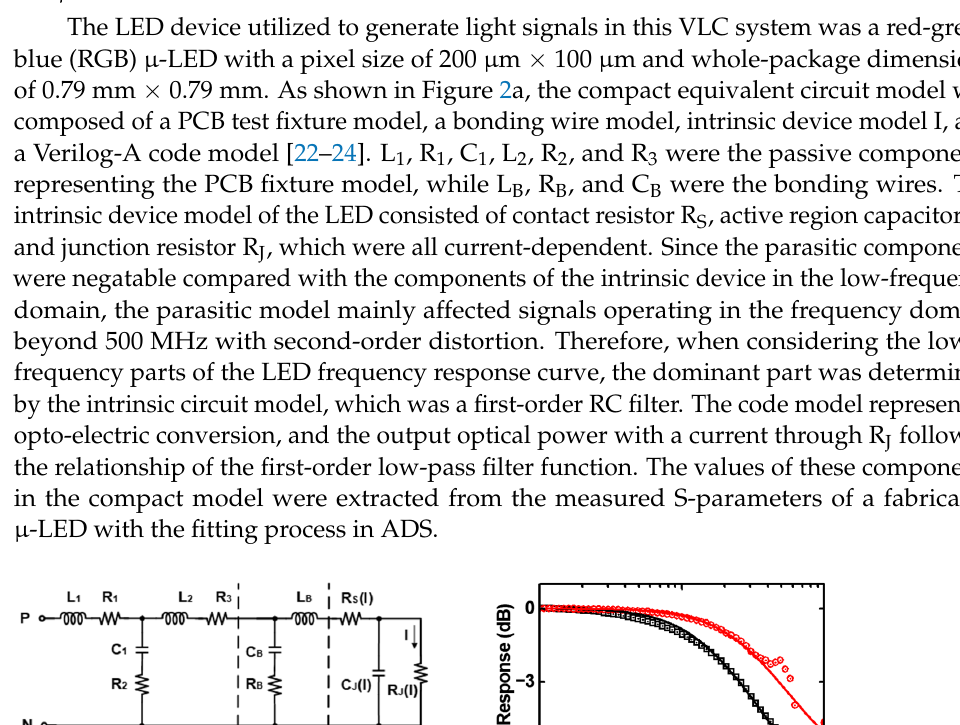
Figure 3. Compact equivalent circuit model of PD. 2.3. Free-Space Channel Model and Underwater Channel Model In the VLC communication system, the most common channel is free space, and the loss of this channel has the aforementioned effects on waveform transmission. For visible light transmission, due to the rectilinear propagation characteristic, this free-space chan- nel can be treated as an LOS channel in which the main restation is signal loss. The gain in the LOS channel can be expressed as below [25]: PL LOS = 10 log 10 (cid:2) A PD (cid:3) m+1 (cid:4) 2πD 2 cos (cid:3) m (cid:4) (cid:3) α (cid:4) cos (cid:5) β (cid:6) G ct G cr (cid:7) ,